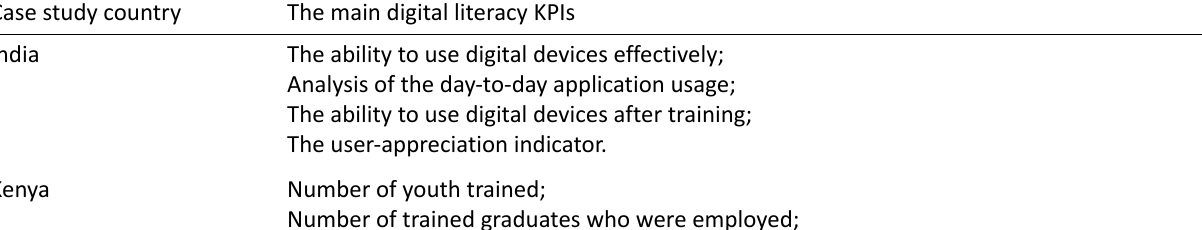
Table 1. Summary of KPIs based on case studies. Case study